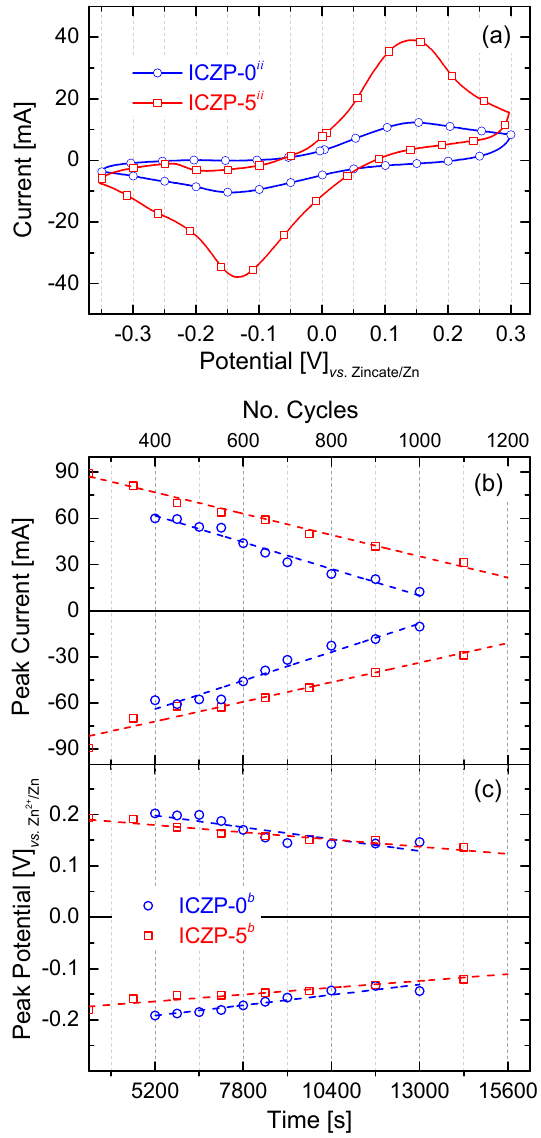
Figure 5. Comparison of ( a ) the 1000th cyclic voltammogram (5 mV s − 1 ) of uncoated (ICZP-0) and 5 wt. % ionomer-coated (ICZP-5) Zn particles in modified ( ii : 4s-2) aqueous alkaline electrolytes. Variation of ( b ) the anodic/cathodic current and ( c ) voltage peaks as a function of time (number of cycles).